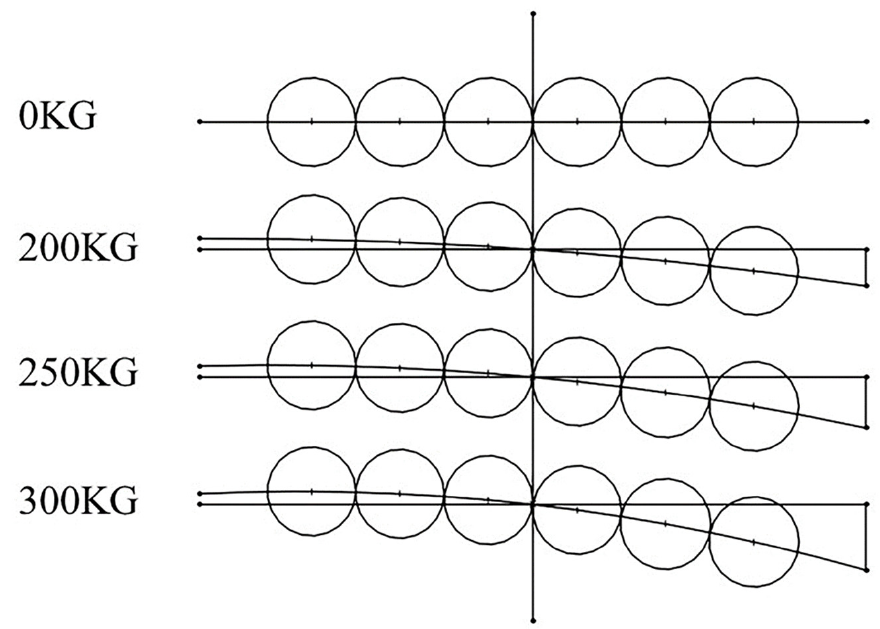
Figure 18. Schematic diagram of pontoon transverse bending.